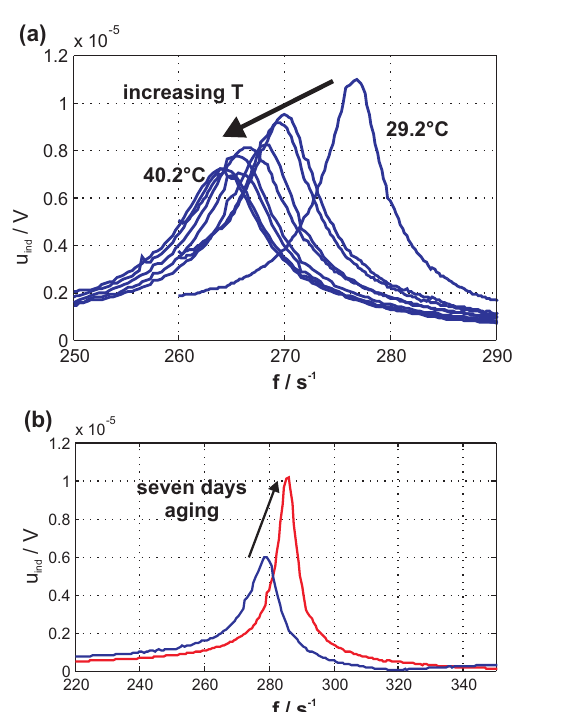
Figure 5. Analysis of the first vibration mode of a 12 × 4mm 2 PE cantilever. (a) shows the decrease of resonance frequency and quality factor due with membrane heating. In (b), the increase of the resonance frequency due to membrane aging is demonstrated.